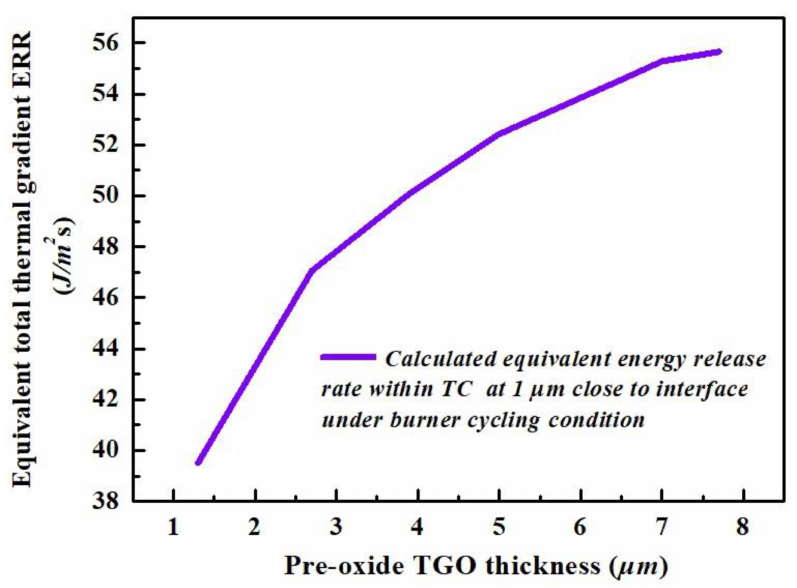
Figure 16. The calculated equivalent total thermal gradient ERR vs. the pre-oxide TGO thickness under burner cycling condition.